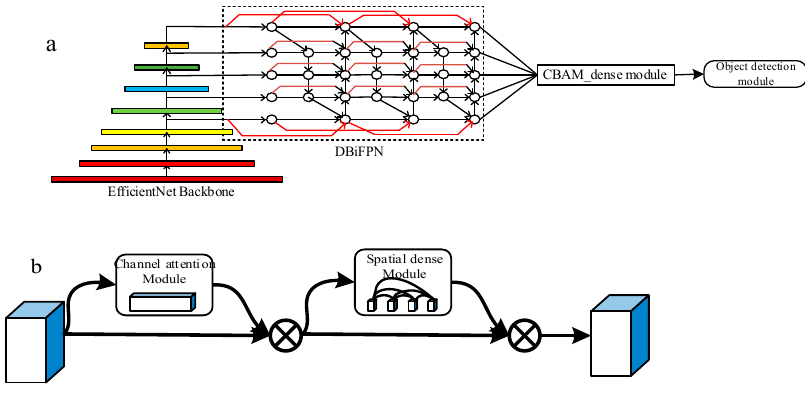
Figure 5. EfficientDet D architecture. ( a ) EfficientDet D and ( b ) CBAM_Dense module.